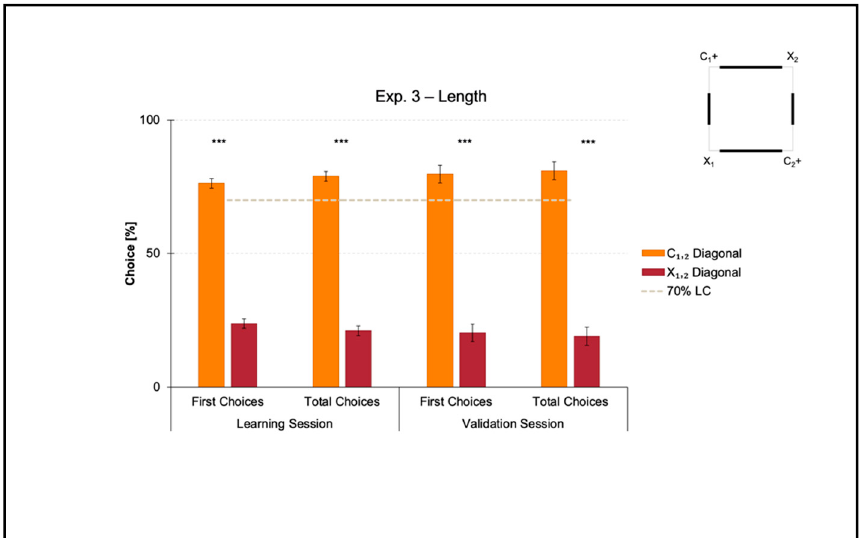
Figure 5. Results of Experiment 3. The bar chart shows the percentages of first and total choices (mean, SEM) obtained by fish towards the two diagonals (C 1,2 versus X 1,2 ) in both learning and validation sessions. The gray dashed line represents the 70% learning criterion (LC), while the asterisks (***) indicate a p- value ≤ 0.001.